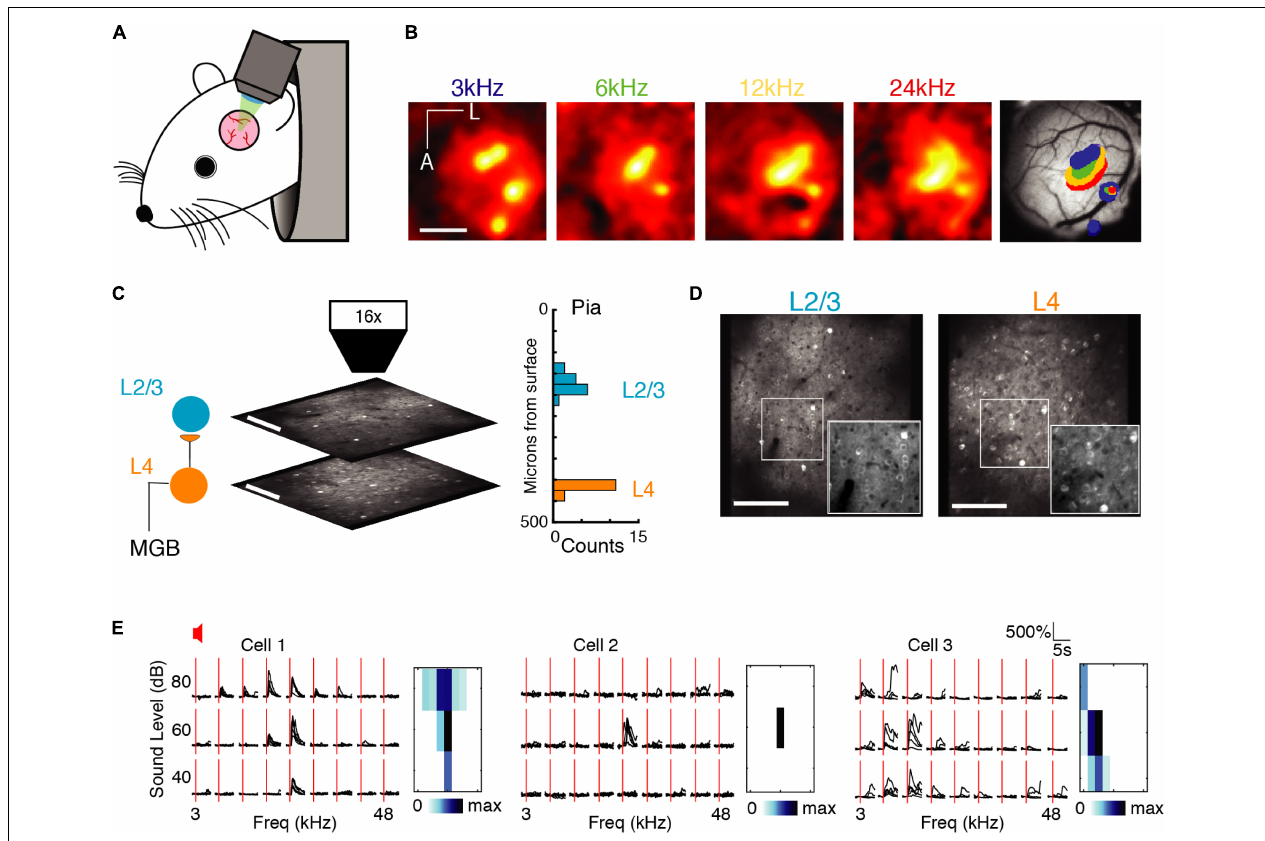
FIGURE 1 | Imaging A1 population activity in the awake mouse. (A) Cartoon of awake mouse under the microscope. (B) Wide-field functional imaging identifies A1. Average activation maps from four different sound frequencies and thresholded activity overlaid on image of brain surface. Tonotopic gradient indicates location of A1. Scale bar = 1 mm. (C) Imaging L4 and L2/3. Histogram shows distribution of imaging plane depths across all experiments. (D) Representative fields of view from L2/3 (left) and L4 (right) showing GCaMP6s expression present in both layers. Scale bar: 100 µ m. (E) Sound-evoked intracellular calcium responses for three pyramidal neurons in A1 to nine different frequencies (column), and three sound levels (row). Each black line indicates a single trial; five repeats per condition, red line indicates sound stimulus onset. Right: Frequency response